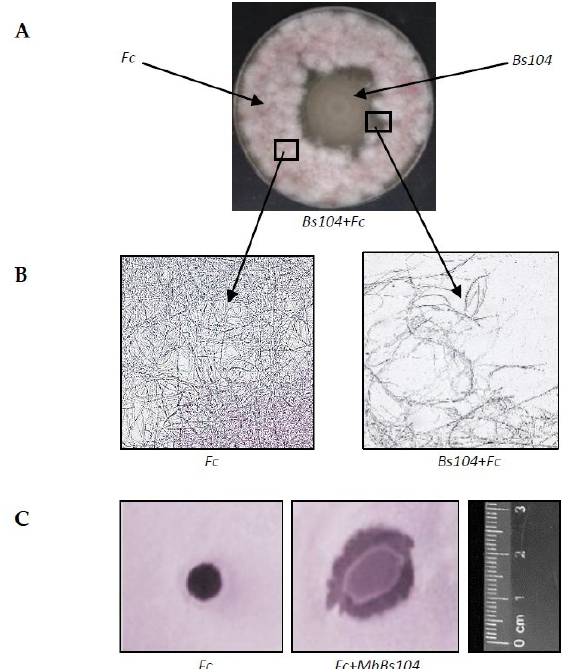
Figure 3. In vitro antagonistic activity of B. subtilis 10–4 ( Bs104 ) against Fusarium culmorum on potato dextrose agar (PDA) plates at 3 days after incubation at 30 ◦ C ( Fc ) ( A ); microscopic visualizations of the growth of Fc and its morphology in the absence ( B ) and on the border with B. subtilis 10–4 ( C ). In vitro antagonistic activity of metabolites synthesized by B. subtilis 10–4 ( MbBs104 ) against F. culmorum ( Fc ) ( D ). The observation was made using a scanning electron microscope (Biozero BZ-8100E (Keyence Co., Osaka, Japan)). Fc — F. culmorum ; Bs104 — B. subtilis 10 – 4; MbBs104 —metabolites synthesized by